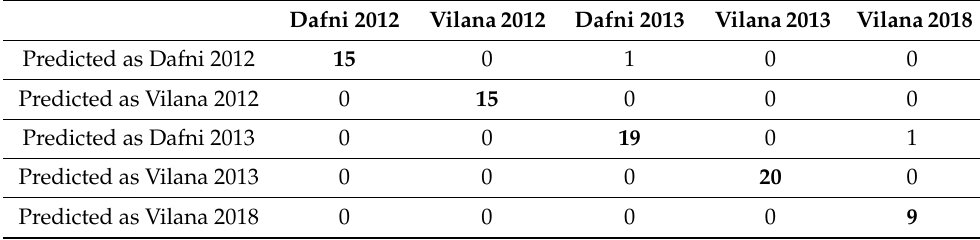
Figure 2. White wine Dafni and Vilana varieties discrimination. ( a ) Score plot of the first and the third latent variables resulting from the OPLS-DA application on ultraviolet spectral data of 80 white wine samples (2012, 2013 and 2018 vintages), and ( b ) The corresponding loading plot. Latent variable 1 is designated by the blue line and latent variable 3 by the red line. Table 1. Classification of white grape varieties (2012, 2013 and 2018 vintages) with